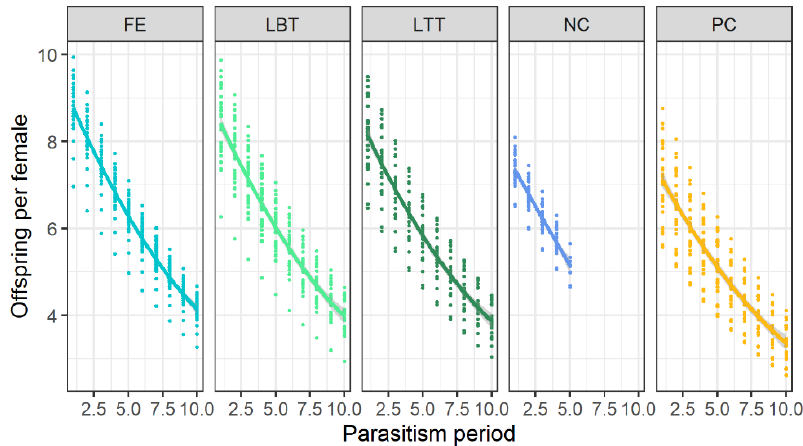
Figure 3. Offspring produced per parasitoid female/period up to the tenth parasitism period (= 23 days of female age). Lines were drawn after fitting GLMM with negative binomial errors to the data of 30 females of Trichopria drosophilae per diet (NC = water, negative control, PC = honey, positive control; flowers of FE = Fagopyrum esculentum , LBT = Lobularia maritima ‘Benthamii’, LTT = L. maritima ‘Tiny Tim’). Parasitism period refers to 2.3 days on average.